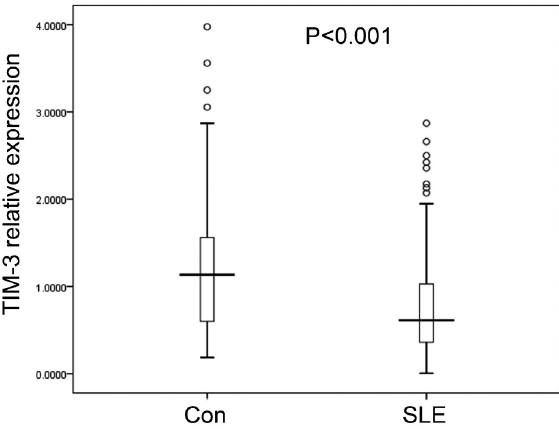
Figure 1. TIM-3 mRNA expression levels in peripheral blood mononuclear cells from systemic lupus erythematosus (SLE) patients (n=132) and healthy controls (Con; n=62). Data are reported in box plots as medians, quartiles, and outsiders (circles). P , 0.001, SLE patients compared to healthy controls (Mann- Whitney